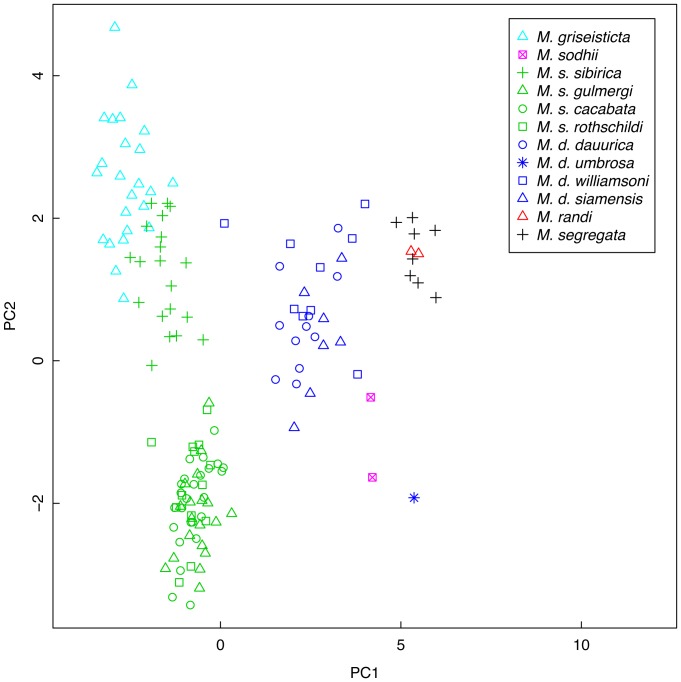
Principal components analysis of morphometric measurements of Asian Muscicapa taxa.